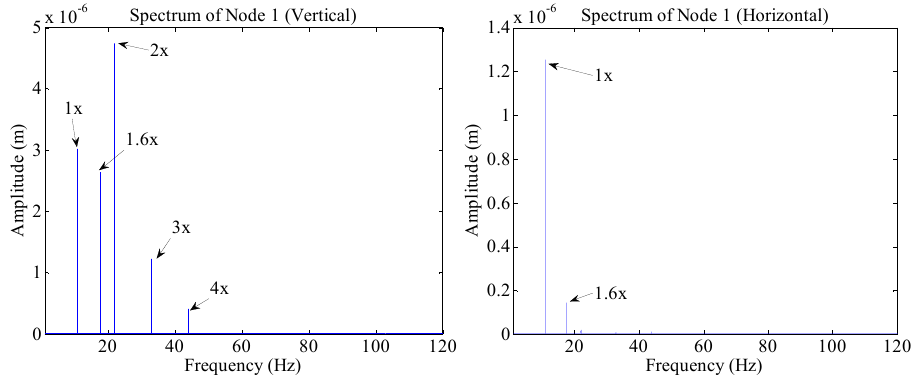
Figure 7. The spectrum of Bearing 1 (misalignment at Bearing 1).